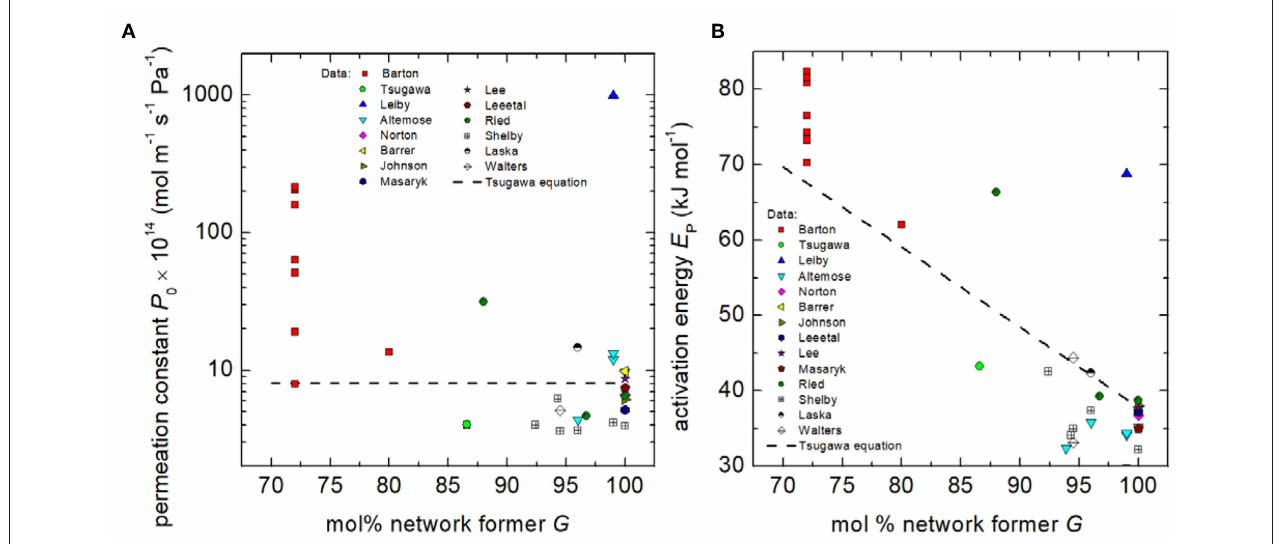
FIGURE 1 | Permeation constant P 0 (A) and activation energy E P (B) of hydrogen and deuterium permeation vs. the molar percentage of network formers G . Data: Barton ( Barton and Morain, 1970), Tsugawa (Tsugawa et al., 1976), Leiby (Leiby and Chen, 1960), Altemose (Altemose, 1961, 1962; Shelby, 1996), Norton (Norton, 1953 ), Barrer (Barrer, 1934), Johnson (Johnson and Burt, 1922), Lee et al. (Lee et al., 1962), Lee (Lee, 1963), Massaryk (Masaryk, 1968), Ried (Ried et al., 2014), Shelby ( Shelby, 1974b, 1977a, 1996), Laska (Laska et al., 1969), and Walters (Walters, 1970). Dashed line represents Tsugawa’s compositional dependence [Equation (4)].